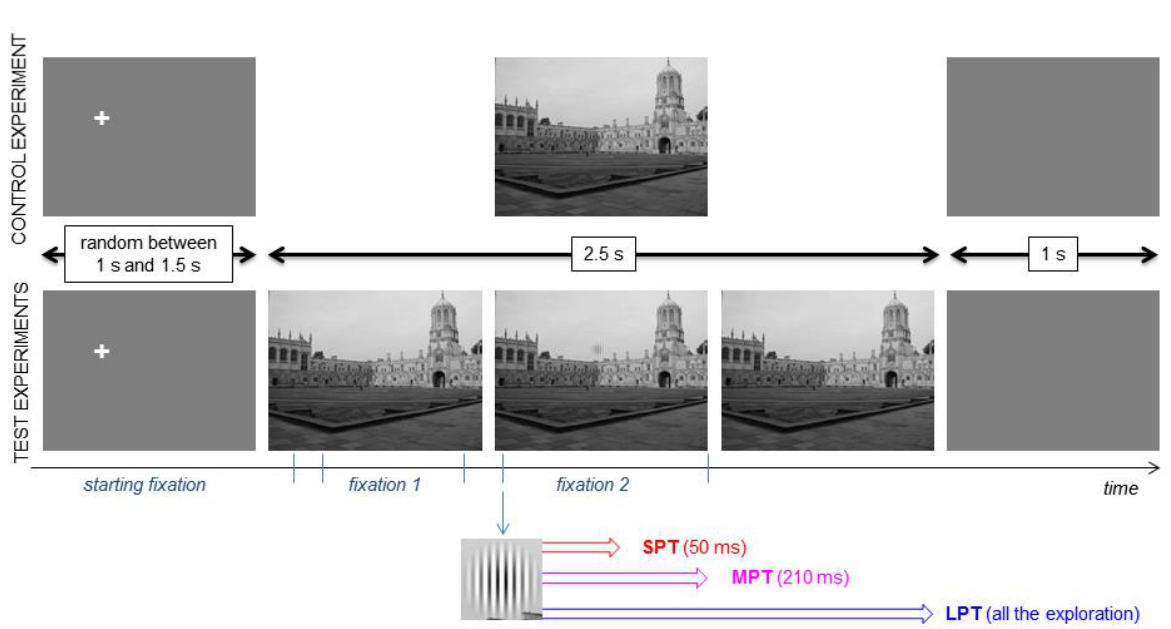
Figure 2: Trial sequence with distractor onset triggered on fixation 2. In the control condition, scenes were displayed without the distractor for 2.5 sec. In distractor conditions, the distractor was displayed for three different durations: 50 ms (Short Presentation Time), 210 ms (Medium Presentation Time) and during the whole exploration (Long Presentation